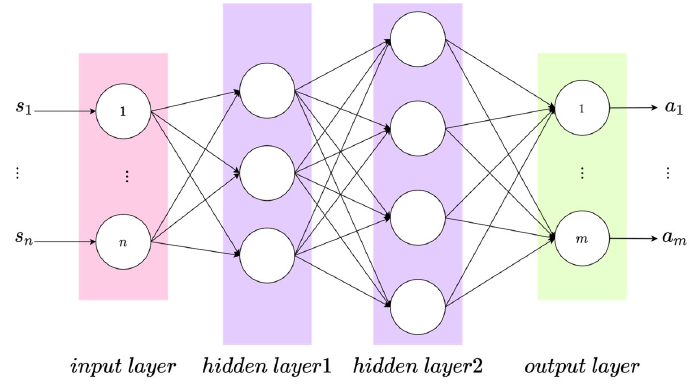
Figure 6. The back propagation neural network.